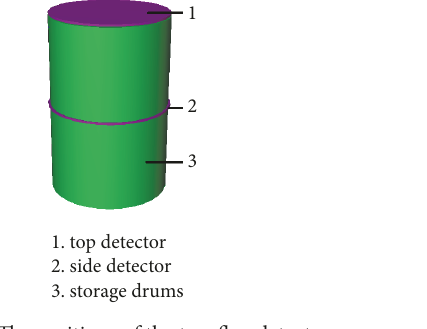
Figure 6: The positions of the two flux detectors. Table 3: Summarization of 𝑁 𝐸 , 𝑁 𝑇 , and Φ R of the four